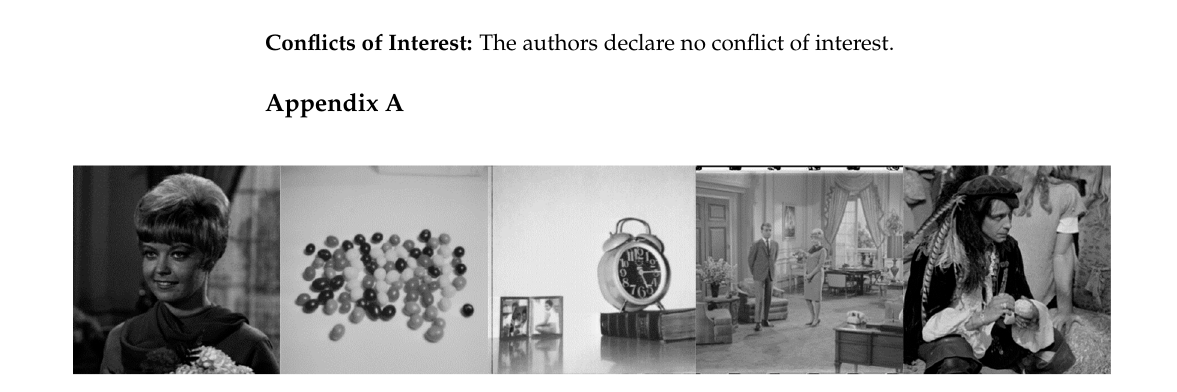
Figure A1. Five additional test images. Table A1. The table of experimental results the PSNR (dB)/SSIM of five additional test images.